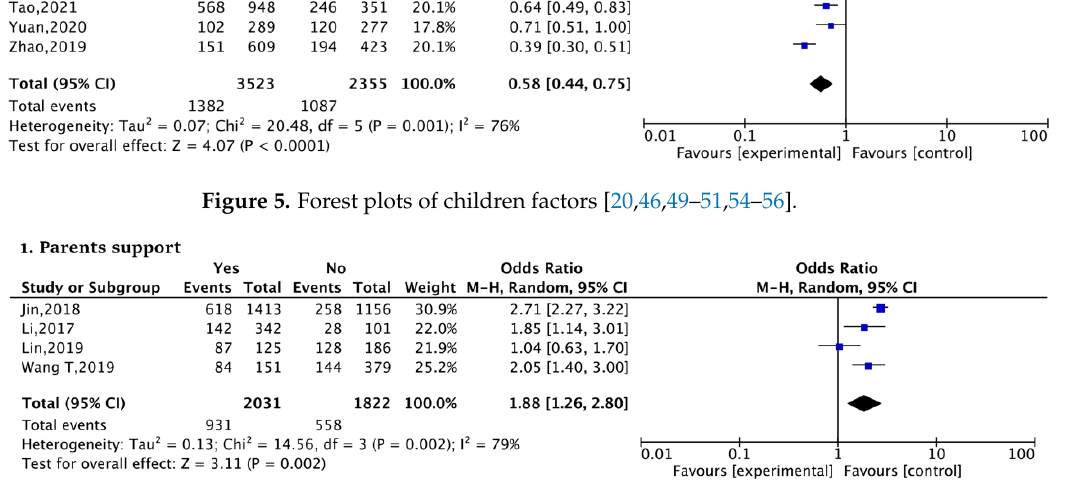
Figure 5. Forest plots of children factors.